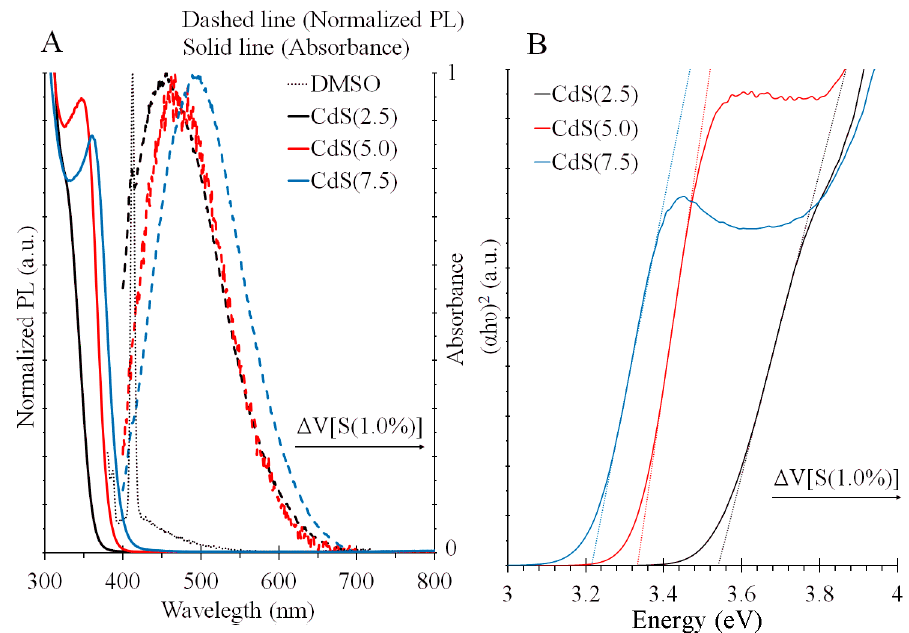
Figure 1. Normalized photoluminescence spectra, pristine optical absorption spectra ( A ) and optical absorption edge calculated using Tauc relation ( B ) for CdS nanoparticles synthesized by different volumes of sulphur in toluene. The 2.5, 5.0, and 7.5 milliliters of sulphur solution per gram of cadmium thiolate were used for the synthesis of each nanoparticle, respectively.